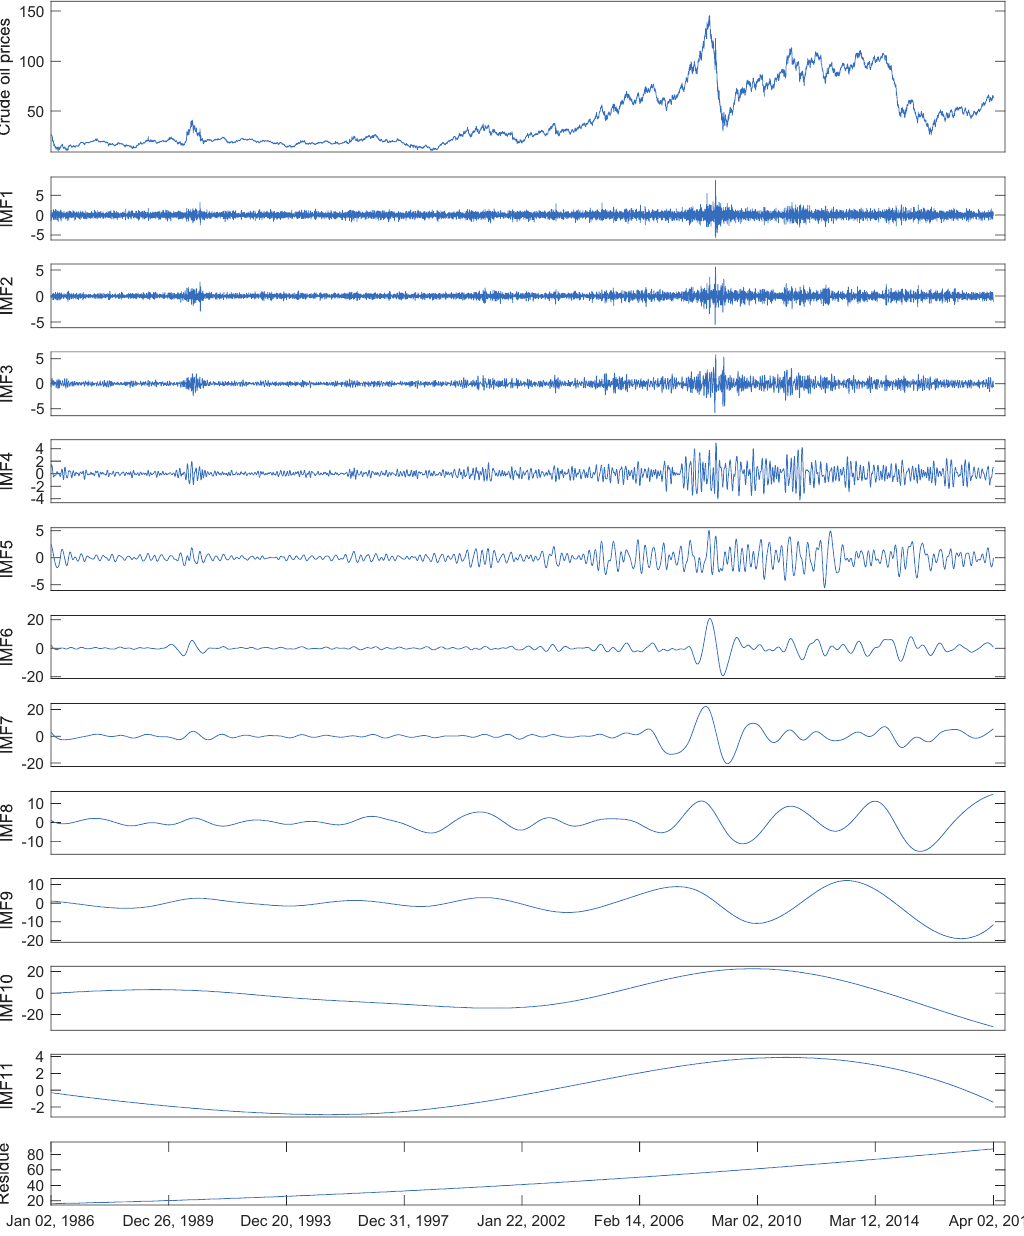
Figure 2. The original data and corresponding components decomposed by EEMD of West Texas Intermediate (WTI) crude oil prices. IMF: intrinsic mode